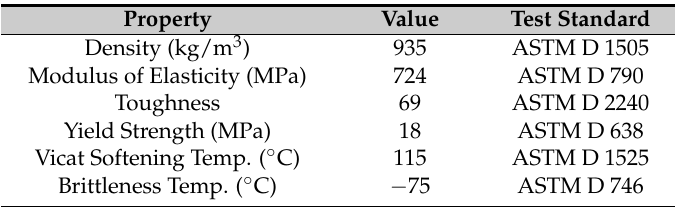
Figure 2. Details of ulukur crash cushion (UCC) ( a ) internal view; ( b ) energy absorbing tube; ( c ) top view; and ( d ) assembled crash cushion. Table 1. Material properties of low-density polyethylene (LLDPE) used in UCC (ulukur crash cushion) design [9,10].